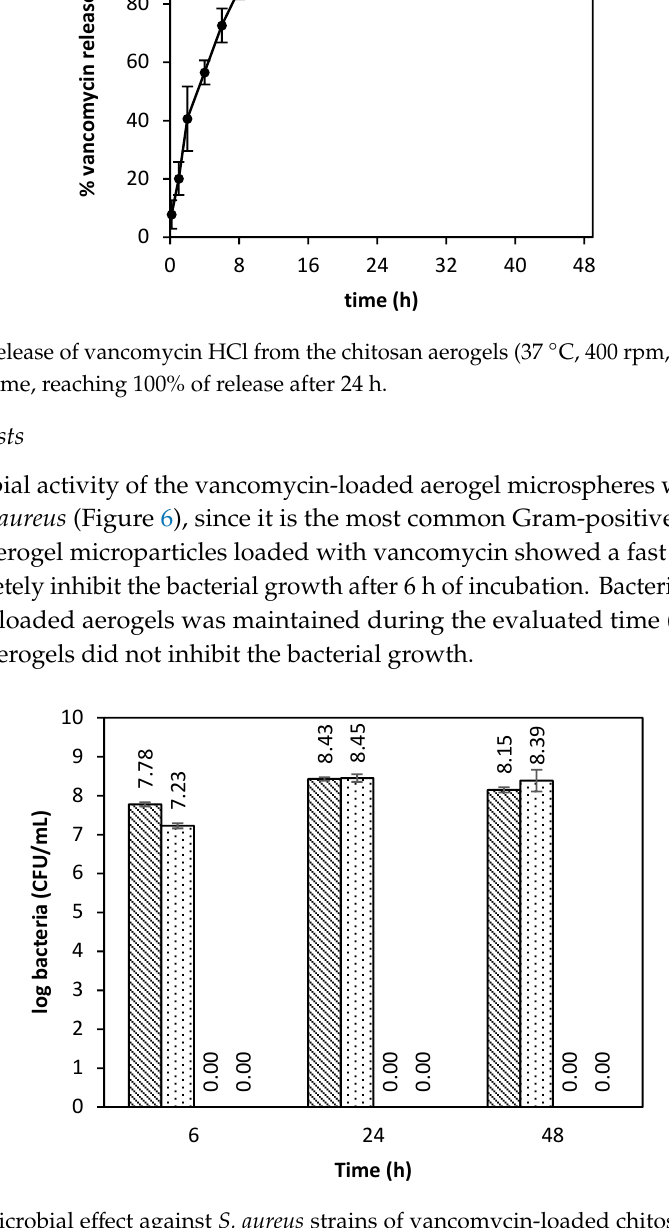
Figure 5. Drug release of vancomycin HCl from the chitosan aerogels (37 °C, 400 rpm, PBS pH 7.4) was sustained over time, reaching 100% of release after 24 h.